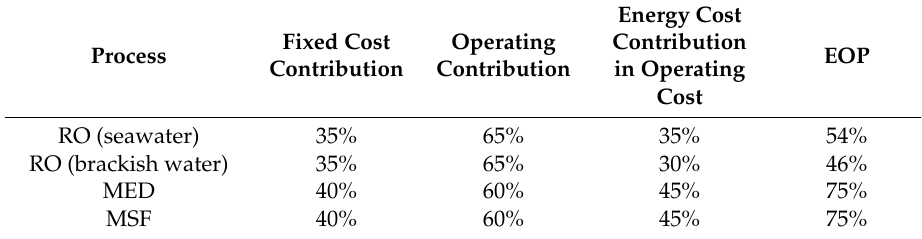
Table 4. Average cost breakdowns of different desalination processes (based on